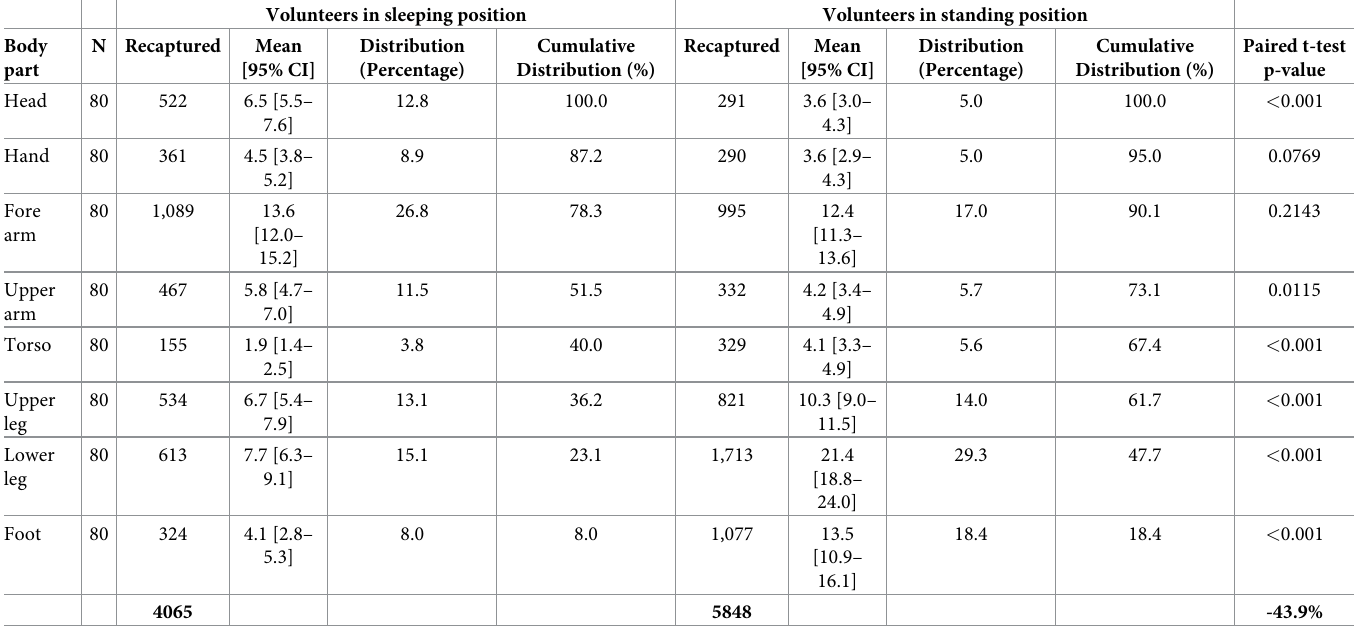
Table 1. Distribution of Aedes aegypti landing sites on bodies of volunteers in sleeping and standing positions. Volunteers in sleeping position